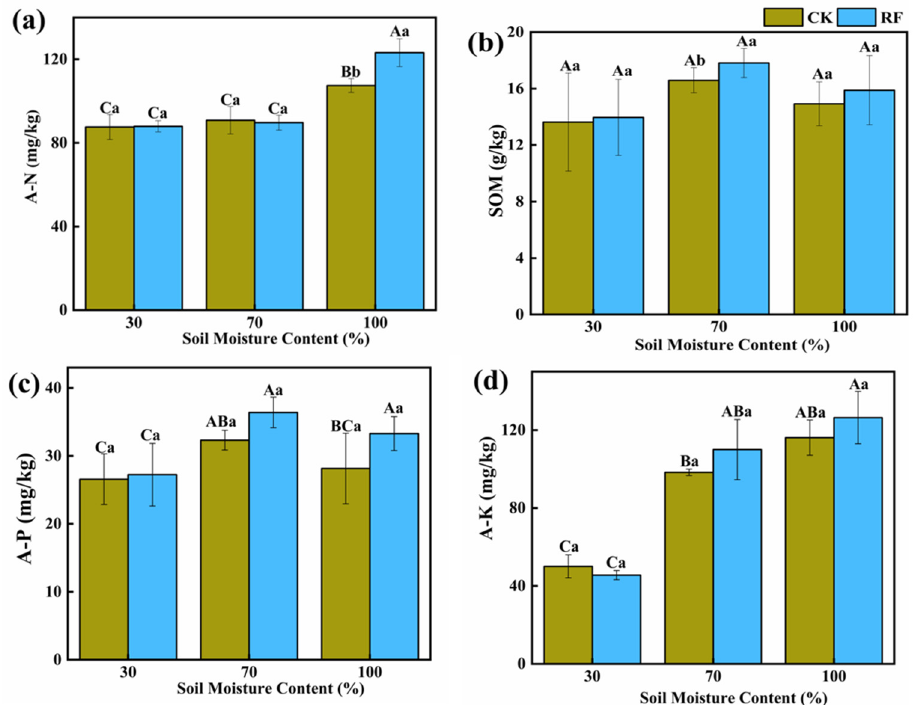
Figure 5. Comparisons of soil nutrients with RF application at different SMCs: ( a ) A-N; ( b ) SOM; ( c ) A-P; ( d ) A-K (uppercase letters and lowercase letters represent significant differences, as explained in Figure 1).